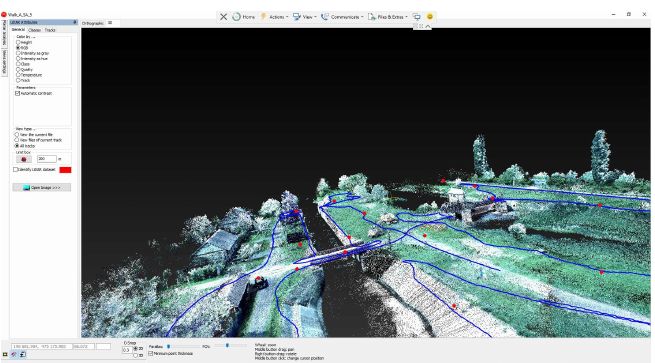
Figure 28. Coloring of LiDAR point clouds by height.